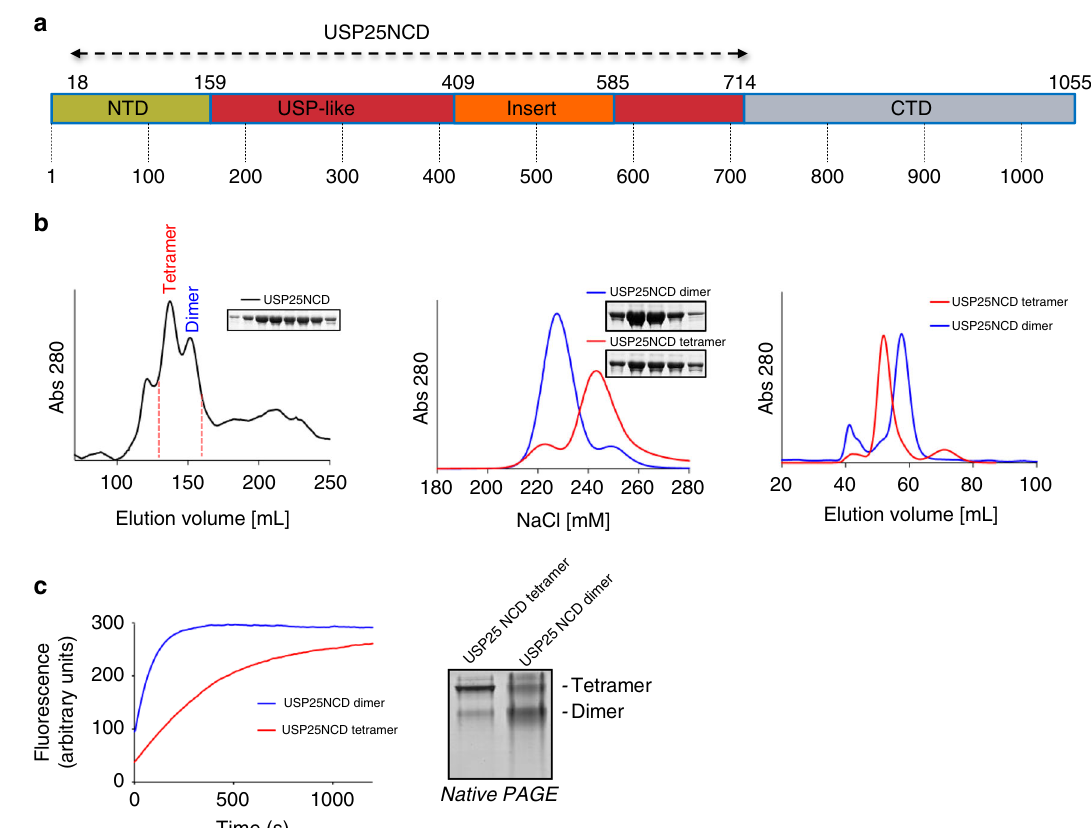
Fig. 1 Recombinant USP25 is produced as a tetramer or a dimer in E. coli . a Scheme of the USP25 protein domains. The construct for crystallization is from residues 18 to 714 (USP25NCD). b First preparative gel fi ltration puri fi cation of USP25 in Superdex 200 column, inset shows the SDS-PAGE of the indicated fractions. Anionic-exchange puri fi cation of the two peak fractions of the previous gel fi ltration, inset shows the SDS-PAGE of the dimer and tetramer fractions. Analytical gel fi ltration puri fi cation of the dimer and tetramer fractions of USP25 in Superdex 16 column. c Plot of the deubiquitinating activity assays of dimer and tetramer with Ub-AMC as a substrate. Non-denaturing native PAGE of the dimer and tetramer fractions of USP25NCD. All uncropped gels and blots are displayed in Supplementary Figure